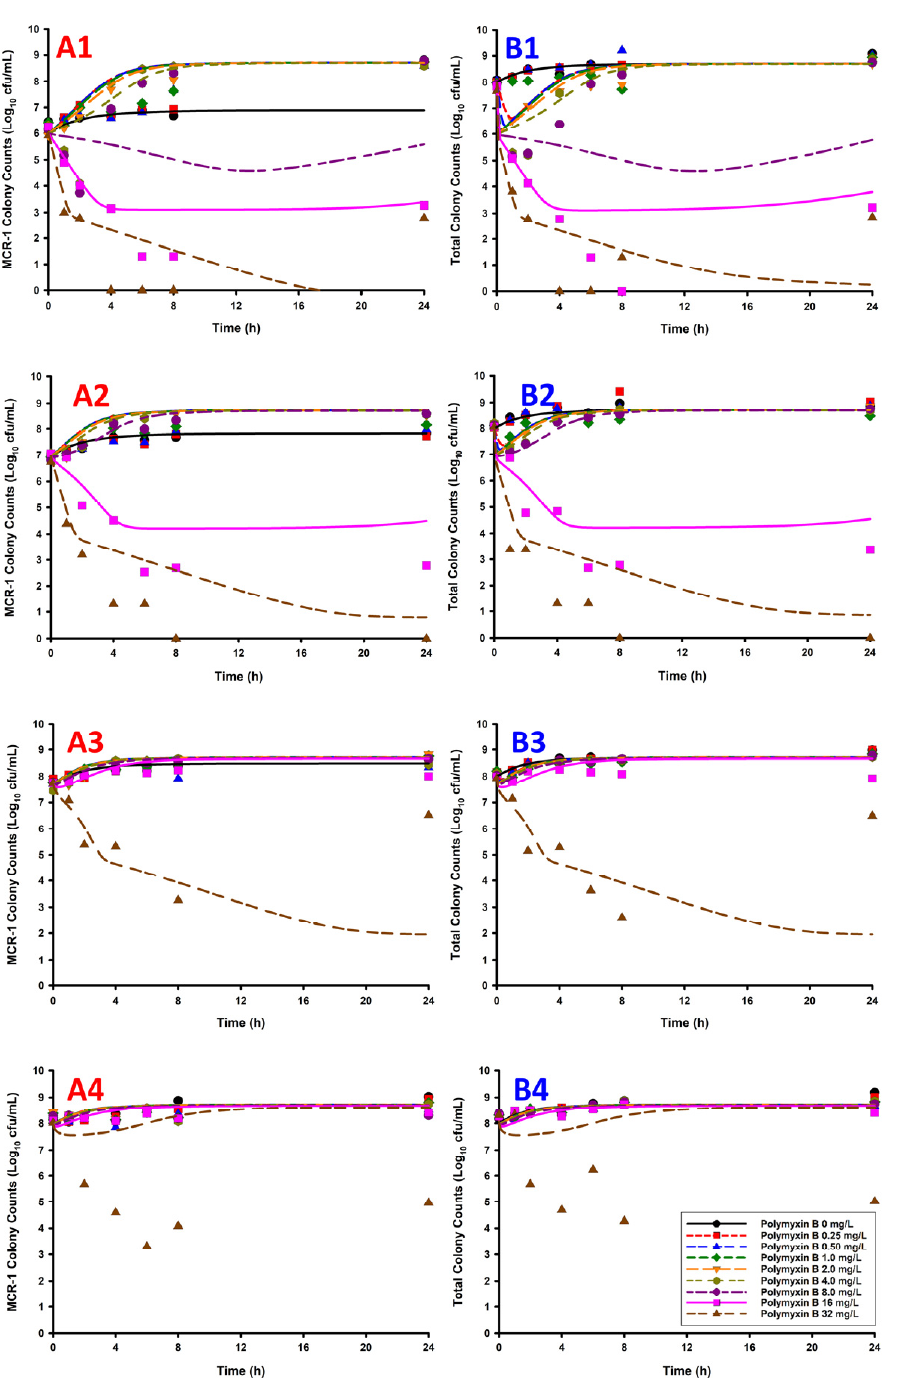
Figure 1. The listed graphs were generated by overlaying the observed bacterial counts from the observed static time-kill data (points) with the simulated bacterial count data (lines, i.e., predicted bacterial counts based on the previously published model) [11]. The counts of the mcr1a-only cells ( A1 – A4 , mcr1a, only) and total population ( B1 – B4 , mcr1a + WT) are represented by each column of panels. For the mcr1a-only panels/total population panels, the plots are listed as: 1% mcr1a + 99% WT ( A1 / B1 ), 10% mcr1a + 90% WT ( A2 / B2 ), 50% mcr1a + 50% WT ( A3 / B3 ), and 90% mcr1a + 10% WT ( A4 / B4 ).